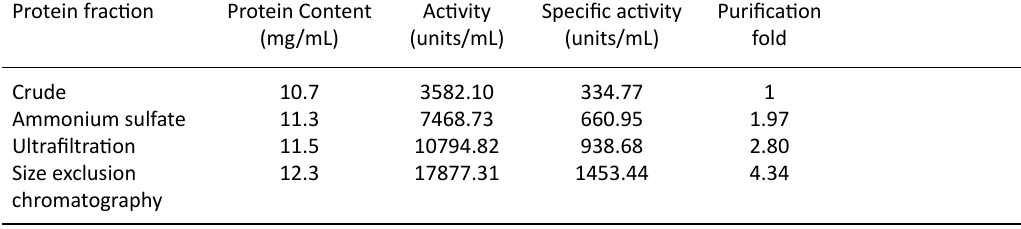
Table 1. Serrapeptase